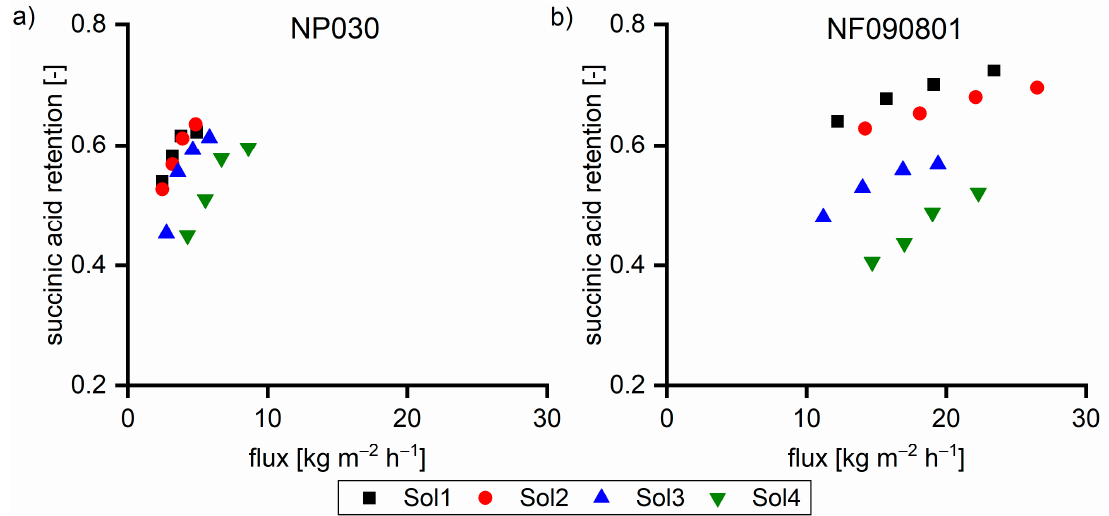
Figure 4. Succinic acid retention of 5 g L − 1 succinic acid in various feed solutions at 40 °C with ( a ) NP030 and ( b ) NF090801. The applied pressure values were 35, 30, 25, and 20 bar, respectively.